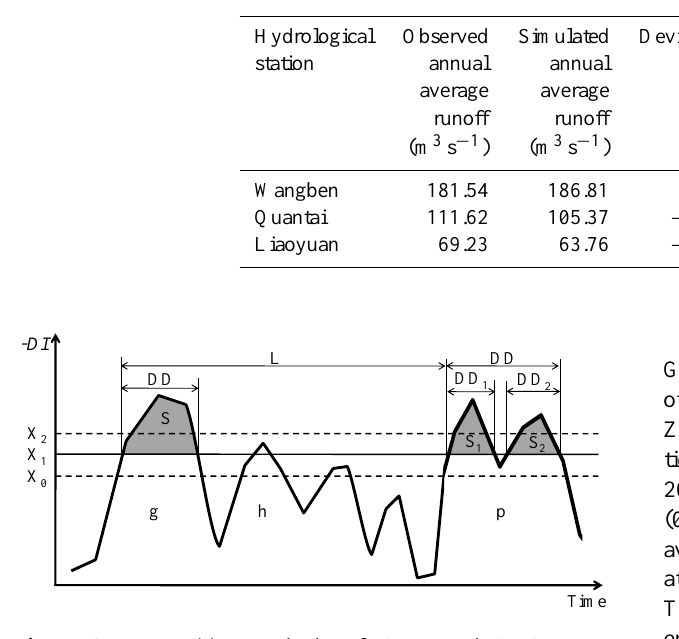
Table 5. Comparing the simulated and observed daily runoff from 2006 to 2010.